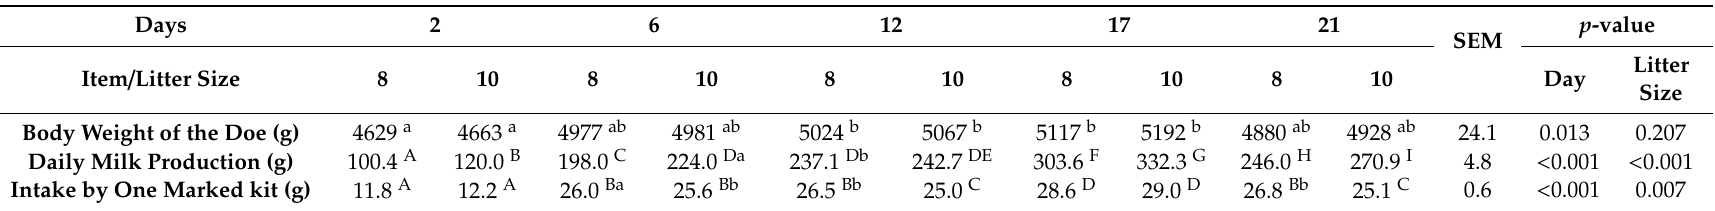
p -value SEM Litter Size